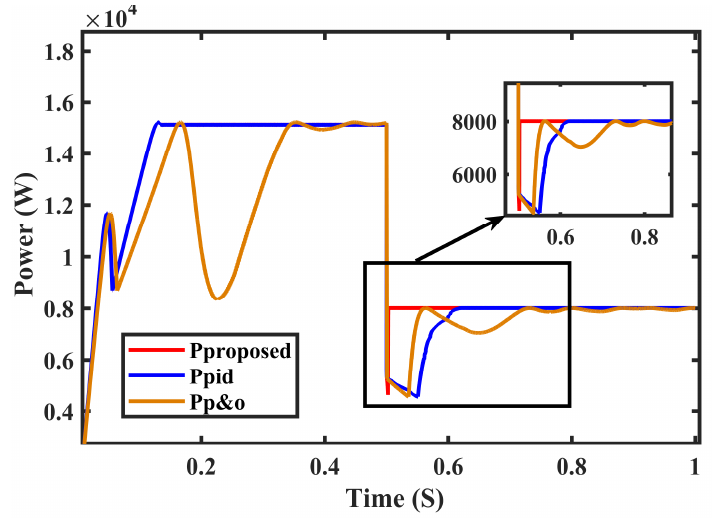
Figure 16. Power analysis with uncertainties.